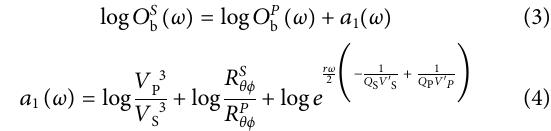
Frontiers in Earth Science |